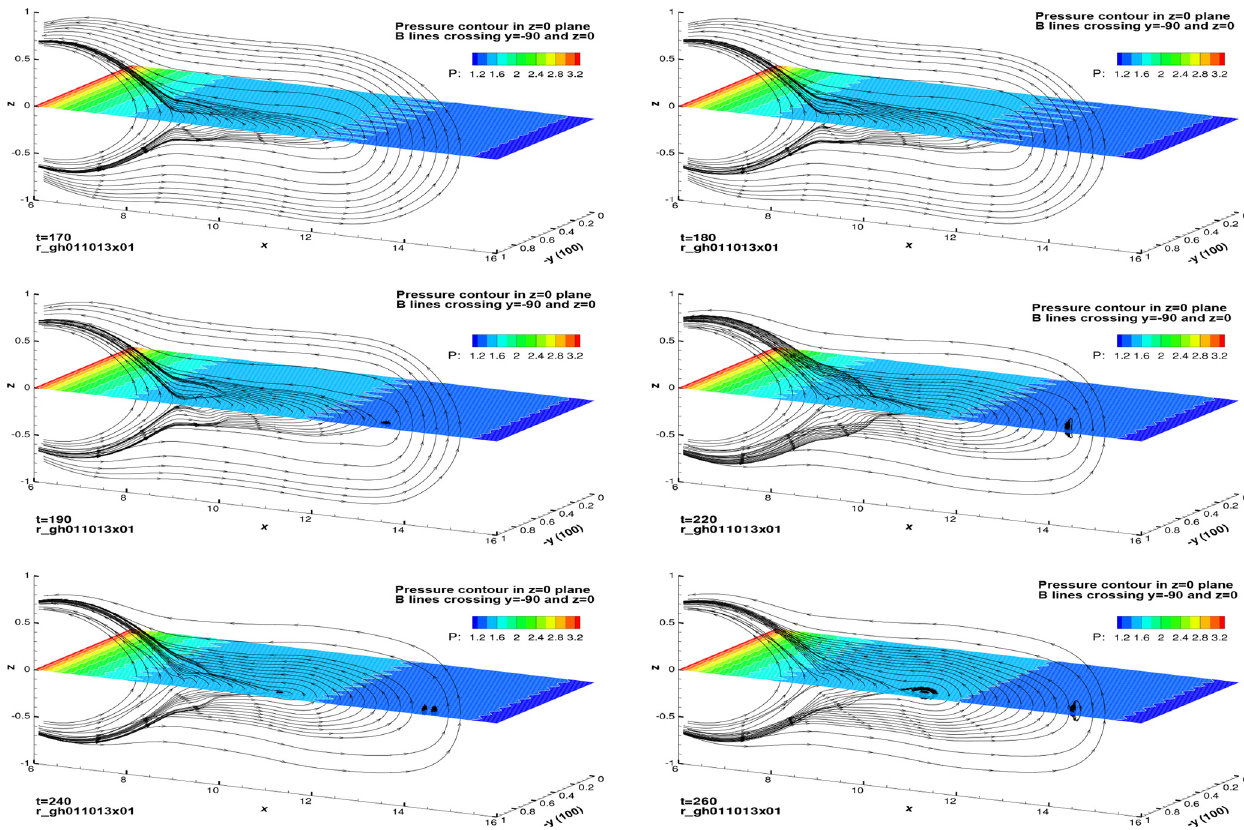
Figure 2. Total pressure contours in the z = 0 plane and magnetic field lines crossing the intersection of the z = 0 and y = − 90 planes at selected time slices ( t = 170, 180, 190, 220, 240, 260). The unit of all the coordinate axes is Earth radius R E . The time unit is Alfvénic time τ A